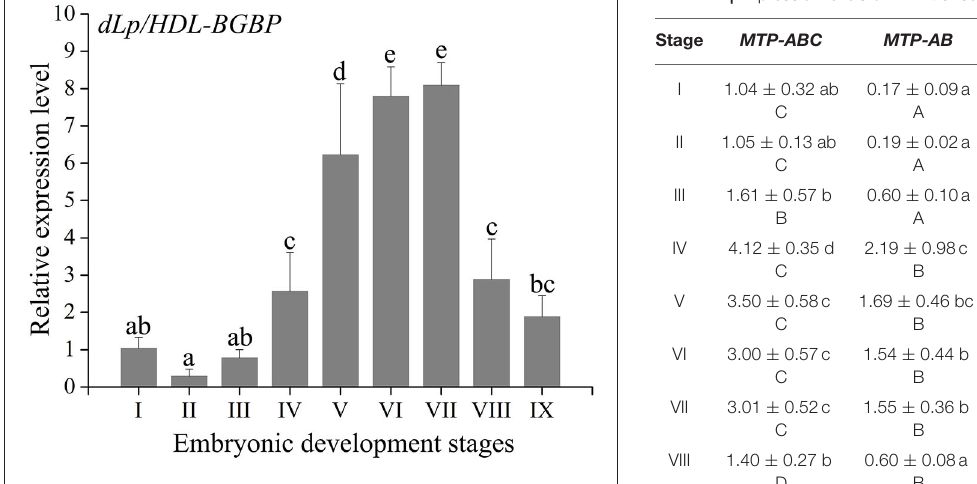
FIGURE 2 | Expression profile of dLp/HDL-BGBP during embryonic development in Scylla paramamosain . dLp/HDL-BGBP, precursor of discoidal lipoprotein and beta-1,3-glucan binding protein. The relative expression level of dLp/HDL-BGBP was determined in blastocyst (I), gastrula (II), nauplius (III), early and late appendage formation (IV–V), early, middle, and late eye pigment formation (VI–VIII), and prehatching (IX) stages of embryos by qPCR, and EF-1 α was the endogenous control. The same letters indicate no significant difference in expression level among embryonic development stages, according to one-way ANOVA in combination with Duncan’s test for post-hoc multiple comparisons. A significant difference was identified at P < 0.05.